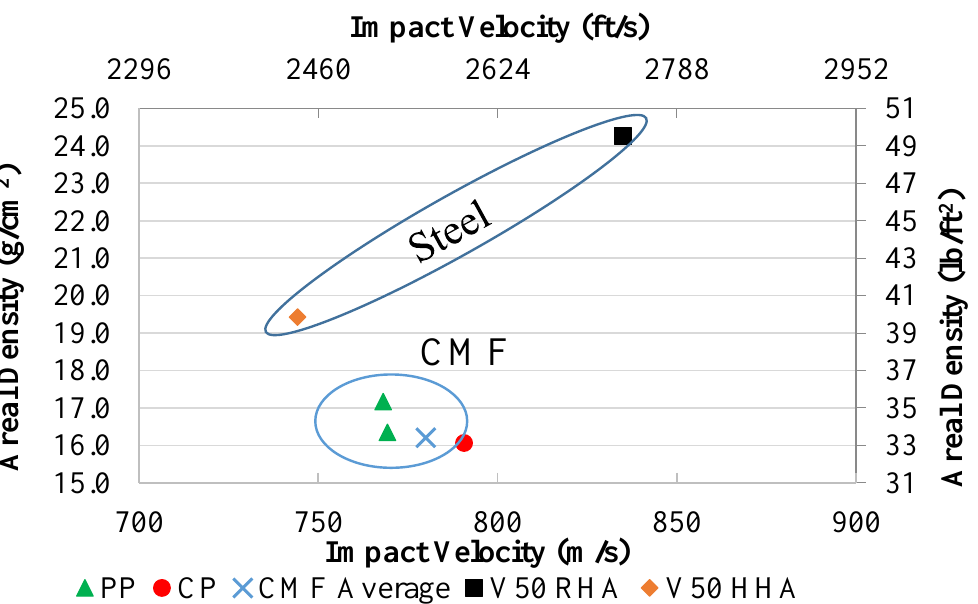
Figure 7. Results of the 14.5 × 114 mm B32 API testing plotted alongside V50 values for both RHA and HHA [4,48,51].